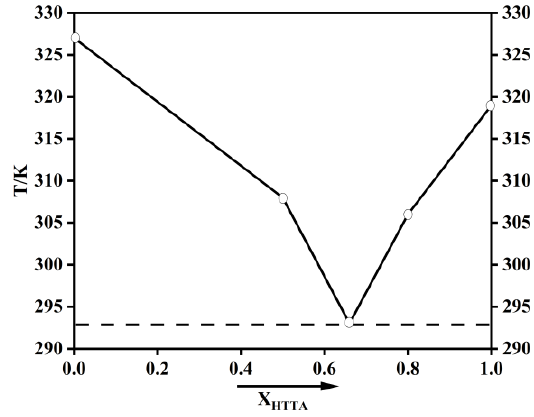
Figure 2. Phase diagram of HTTA and TOPO. Table 1. Density and viscosity, DES (molar ratio: HTTA/TOPO = 2/1). Material Density [g/cm 3